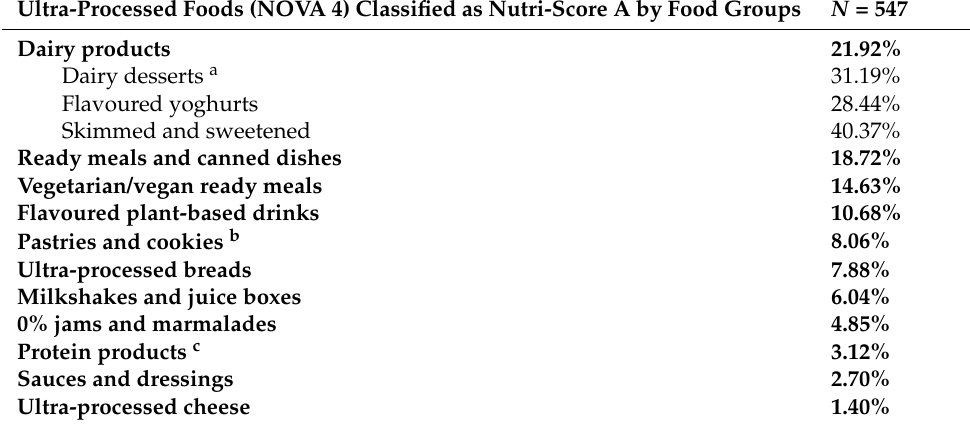
Table 2. Relative contribution of ultra-processed food groups (NOVA 4) in the Nutri-Score A classification.